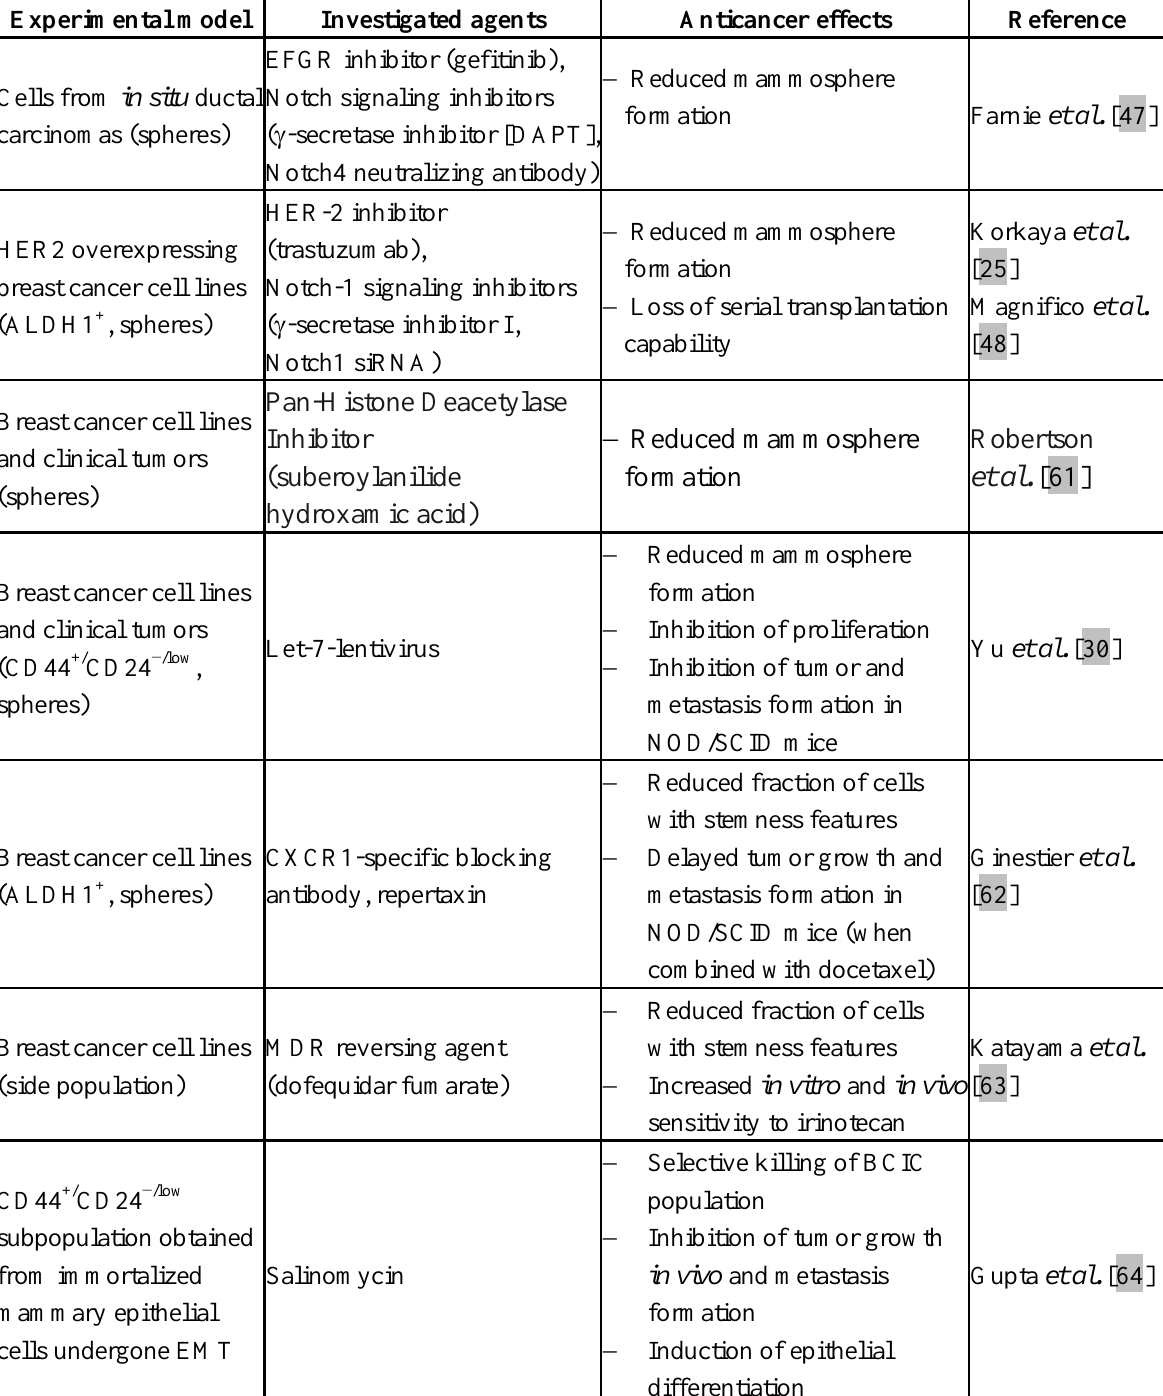
Table 2. Breast cancer-initiating cells and potential